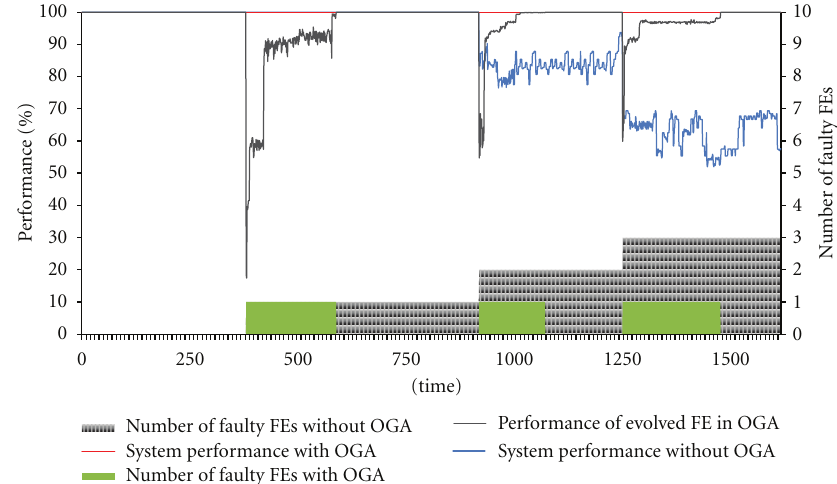
Figure 11: Holistic experiment to demonstrate the interaction between RARS and OGA.